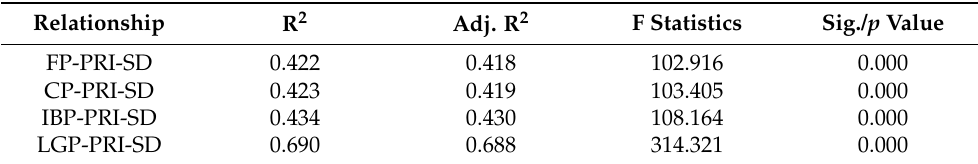
Table 7. Mediation